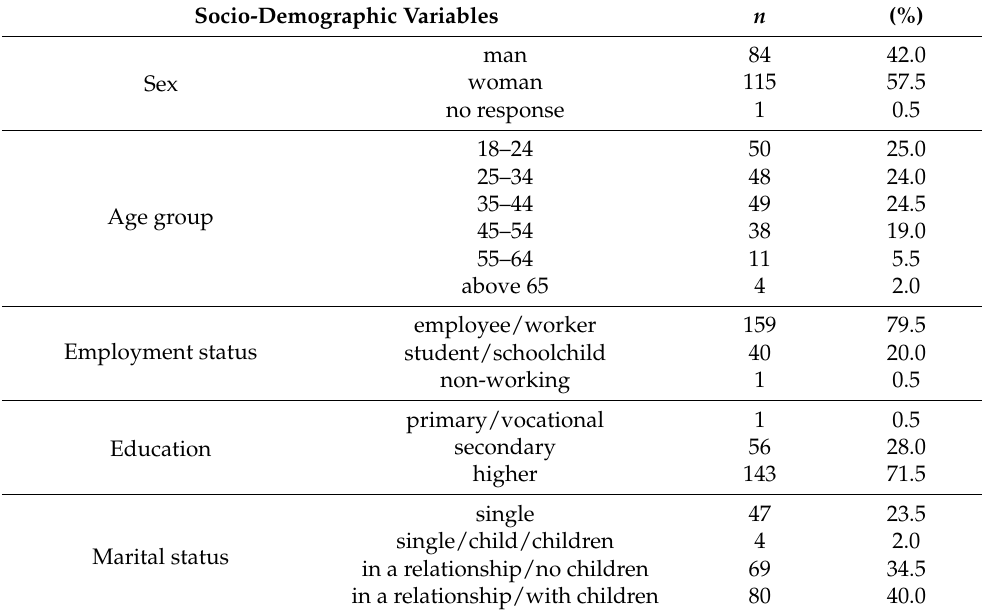
Table 1. Test sample